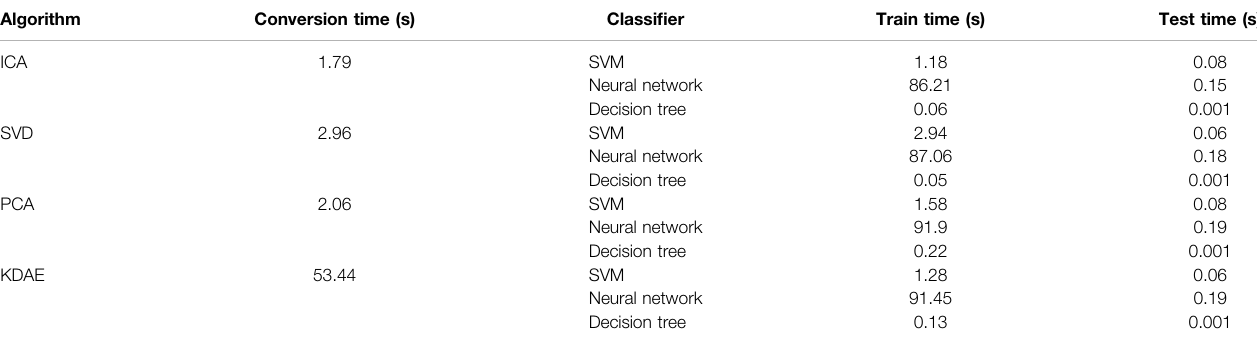
TABLE 6 | Time consumption in different algorithms.